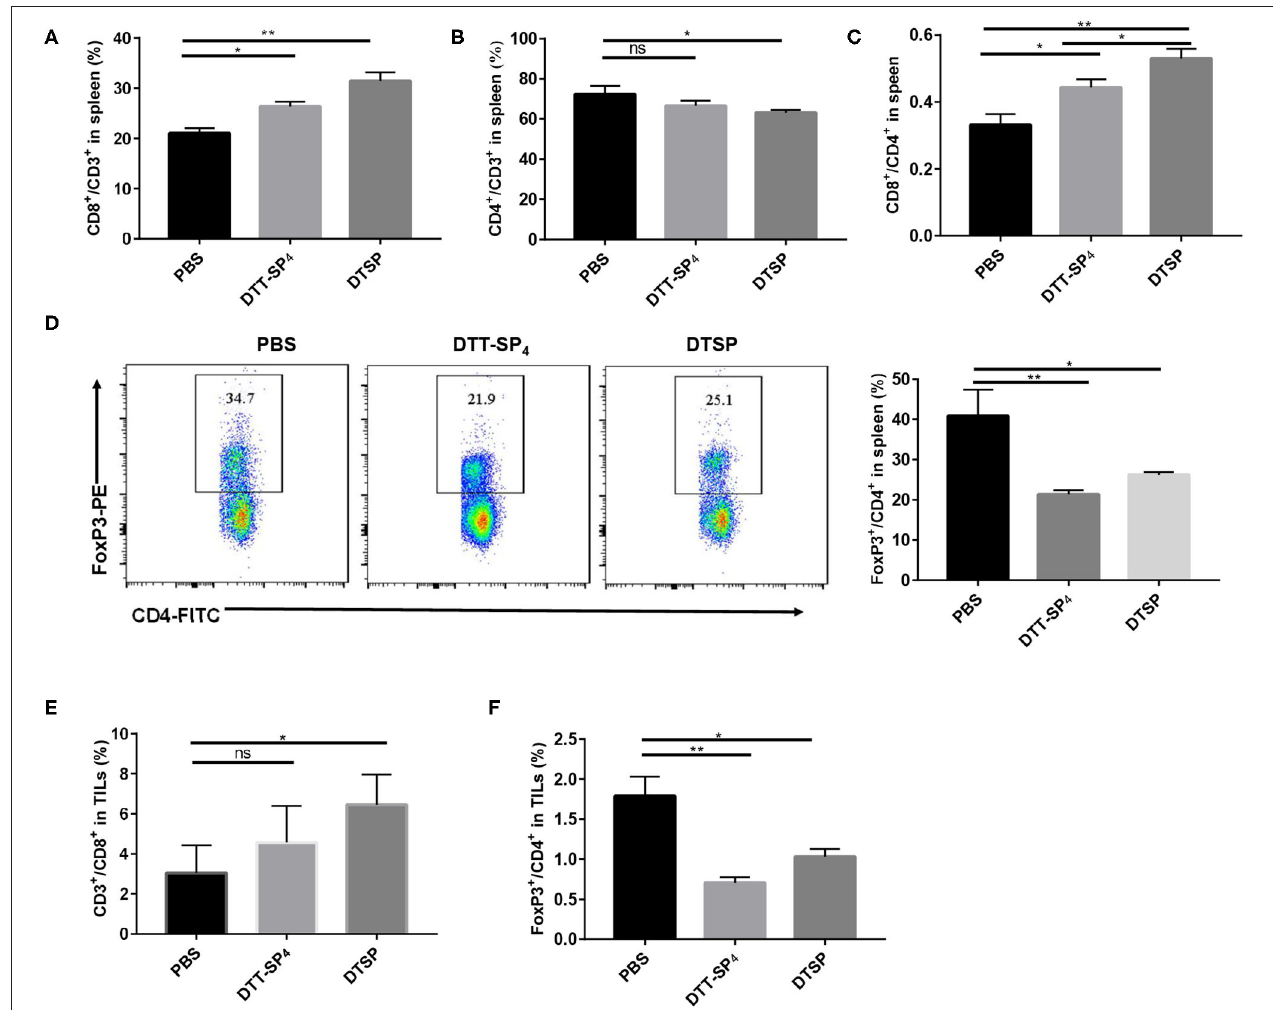
FIGURE 6 | Distribution of CD4 + T cells, CD8 + T cells, and CD4 + Foxp3 + cells in spleens or TILs of tumor-bearing mice. Mice ( n = 3) were sacrificed when tumor sizes reached nearly 1,000–1,500 mm 3 . (A–F) Splenocytes isolated from the control, DTT-SP 4 -treated, or DTSP-treated group were divided into two tubes at 1 × 10 6 cells/tube and then stained. One tube was stained with anti-CD4-FITC, anti-CD8-PE, and anti-CD3-PercP5.5 antibodies. The other tube was stained with anti-CD4-FITC and anti-CD3-APC antibodies and further stained with anti-Foxp3-PE antibody after fixation and permeabilization. (A) The proportion of CD8 + /CD3 + T cells. (B) The proportion of CD4 + /CD3 + T cells. (C) Ratios of CD8 + T cells to CD4 + T cells. (D) The proportion of Foxp3 + /CD4 + T cells. (E,F) Freshly isolated TILs were divided into two tubes with 1 × 10 6 cells/tube and then stained following the procedure followed for splenocyte staining. (E) The proportion of CD8 + CD3 + T cells. (F) The percentage of Foxp3 + CD4 + T cells. Data are presented as means ± SD. * p < 0.05, ** p < 0.01, ns, not significant, Student’s t -test.